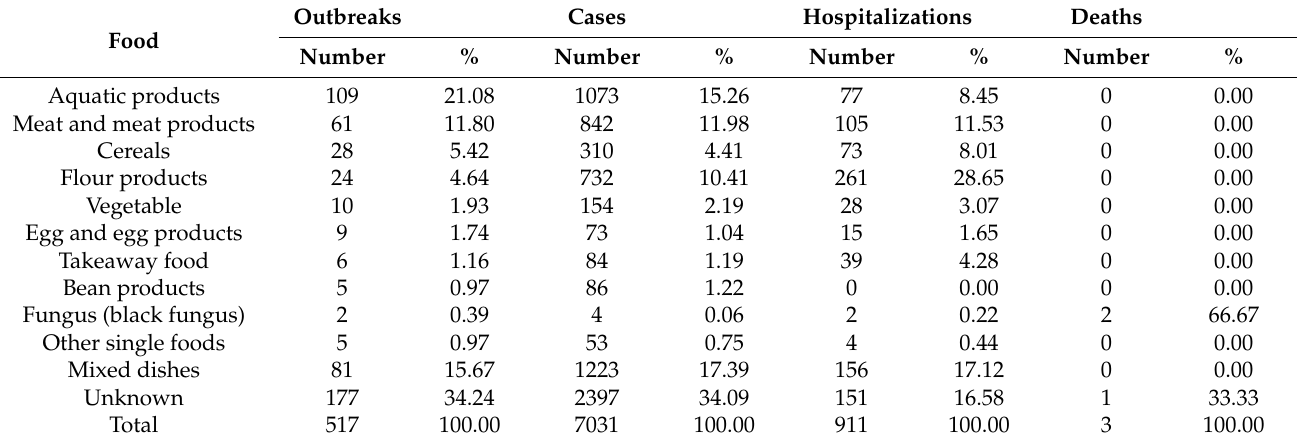
Table 4. Food distribution of outbreaks of bacterial FBDOs in Zhejiang Province, 2010–2020.